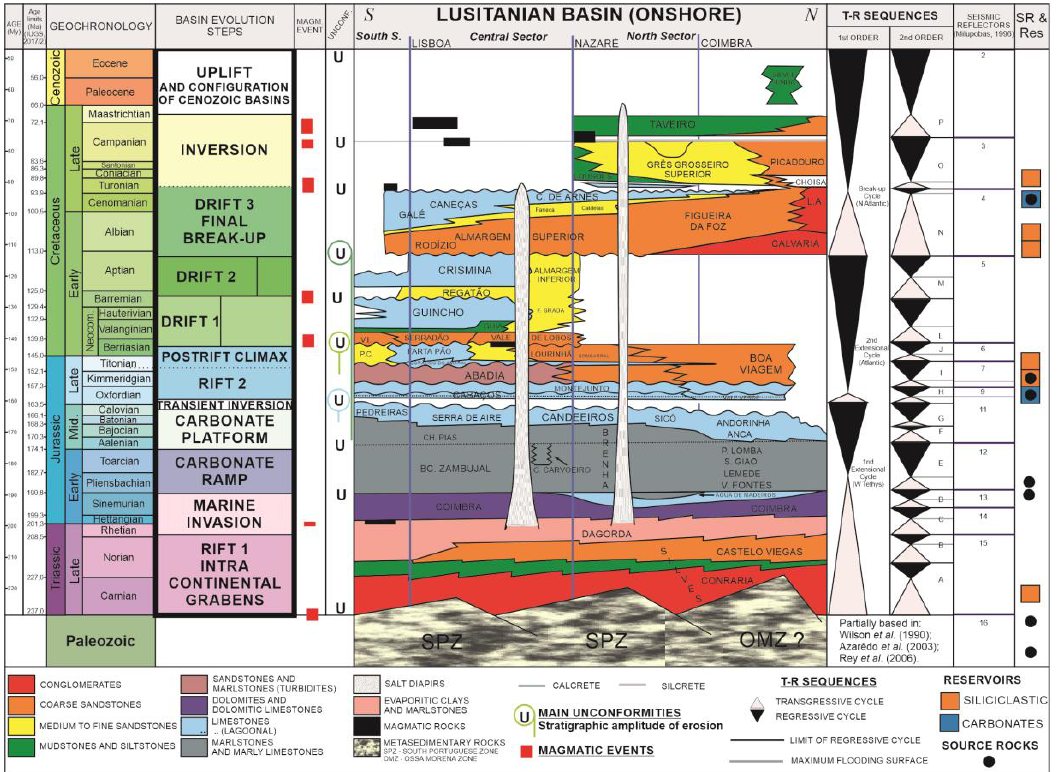
Figure 4. Chronolitostratigraphic chart of the Lusitanian Basin, adapted from Pena dos Reis and Pimentel